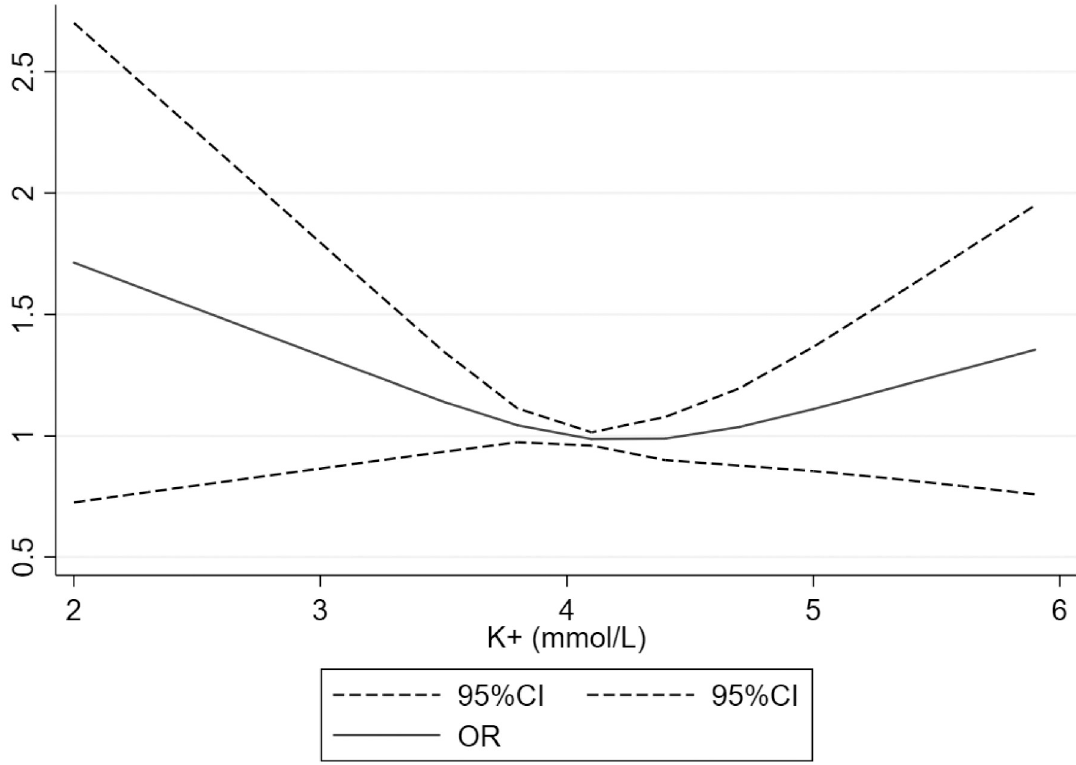
Fig 3. Relationship between potassium level in blood and combined outcome of hospitalization or death. � Model adjusted for age, gender, estimated glomerular filtration rate, hemoglobin and thiazide diuretics.